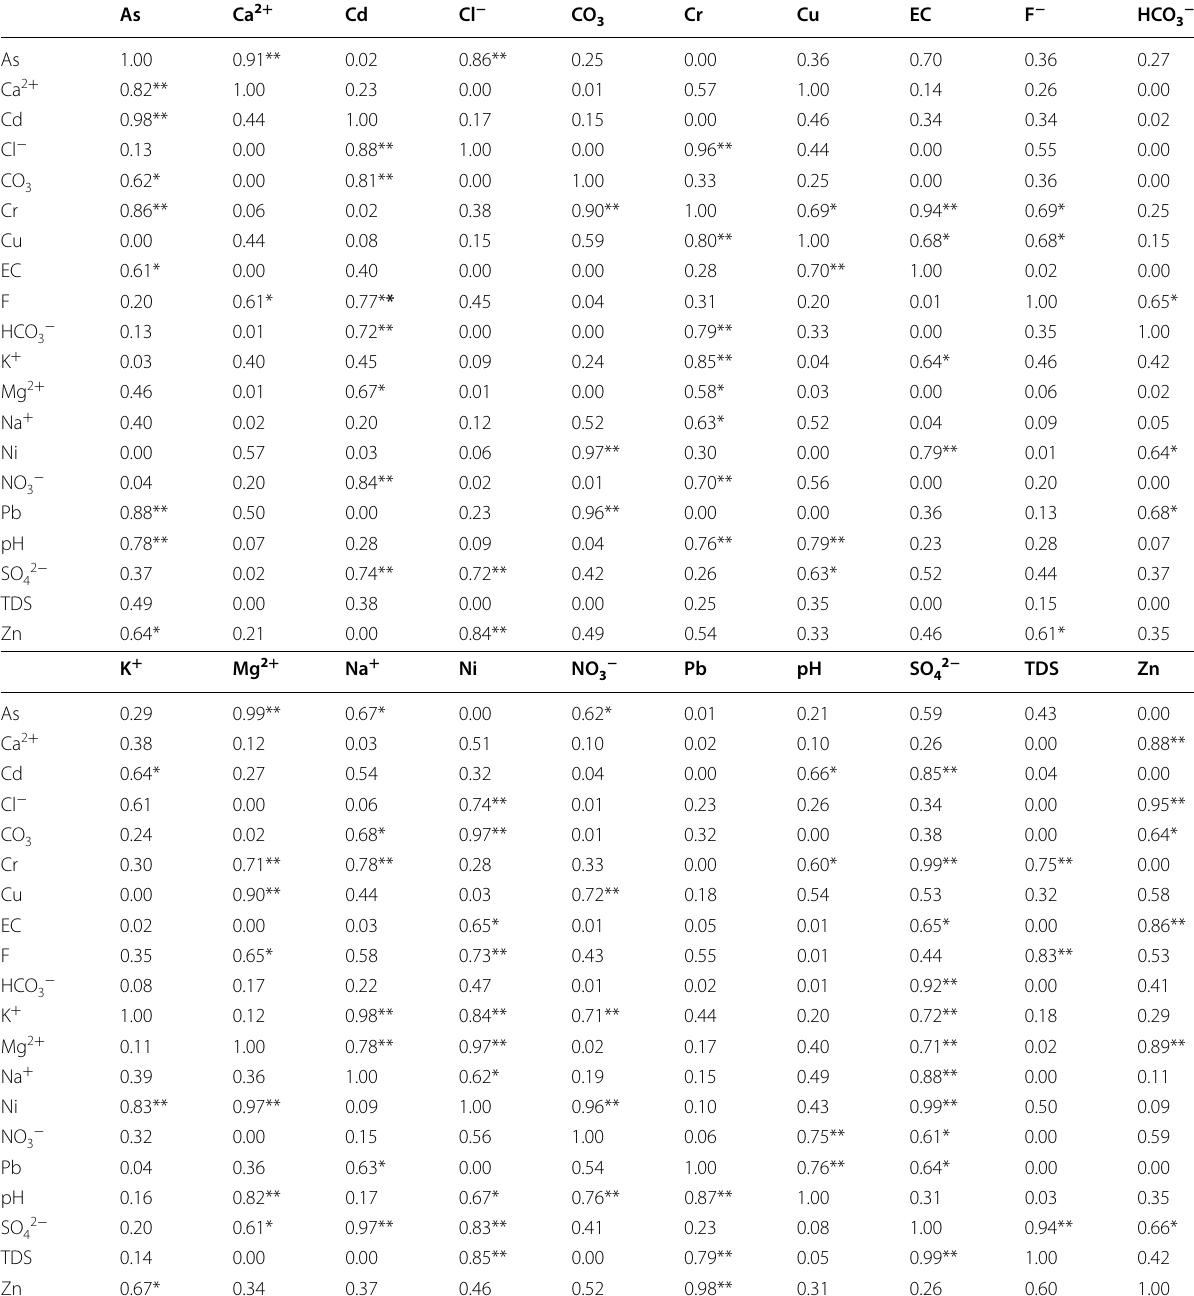
Table 5 Correlation coefficient (r) matrix of cations, anions and selected metals in groundwater during summer season (above the diagonal) and winter season (below the diagonal; n =